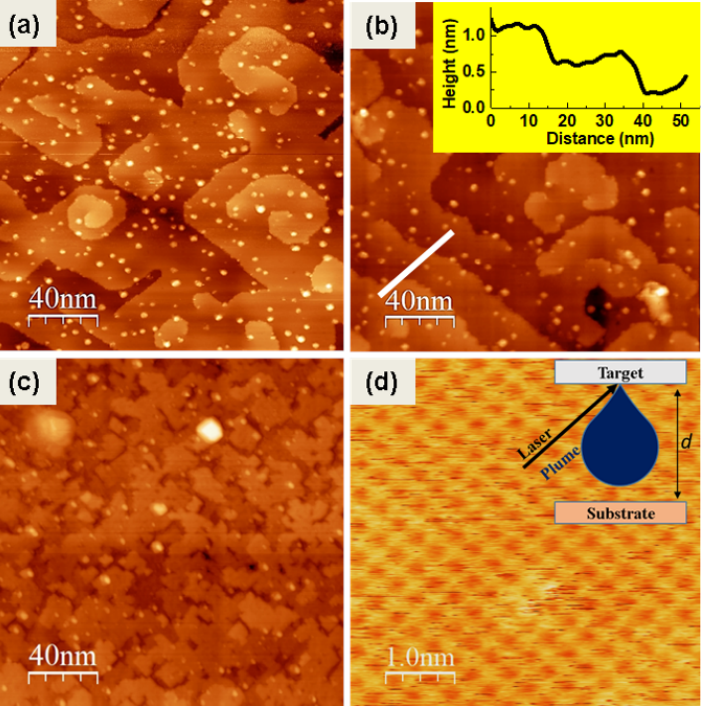
Figure 3. STM topography of a FeSe film grown by PLD. 28 uc film deposited at ( a ) d = 6.8 cm, ( b ) d = 7.5 cm, respectively. Inset to ( b ): line profile measured along the solid line in ( b ). ( c ) 1.5 uc FeSe deposited at d = 7.5 cm, ( d ) (5 × 5) nm 2 atomic resolution STM topography of the surface in ( a ). Inset to ( d ): Schematic of the PLD